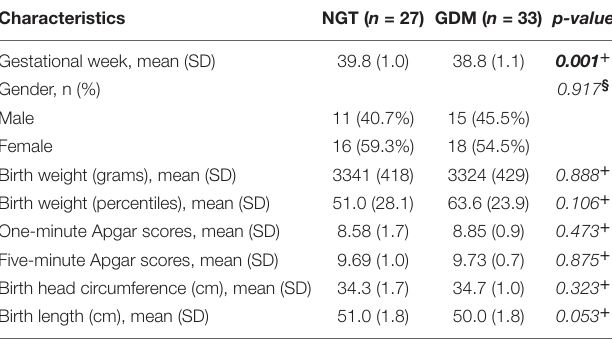
TABLE 1 | Clinical characteristics of normoglycemic (NGT) and gestational diabetes (GDM) women expressed as mean and standard deviation (SD) and absolute frequency (n) and column percentage (%).